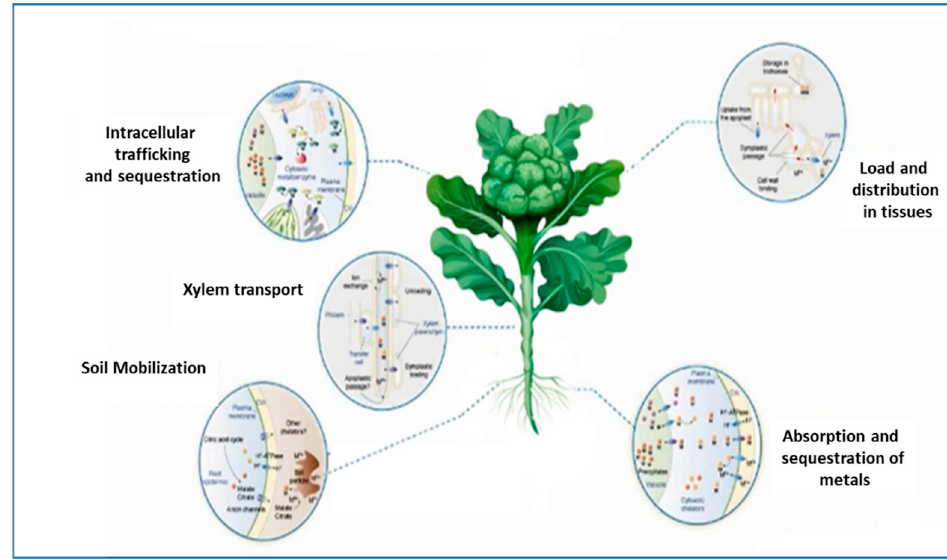
Figure 1. Dynamics of cadmium in broccoli plants according to the bibliography consulted.